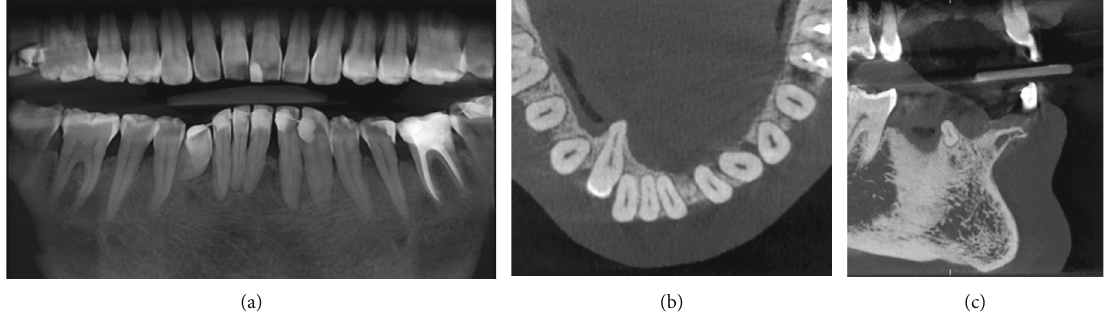
Figure 2: CBCT initial images: coronal (a); axial (b); and sagittal (c) sections.